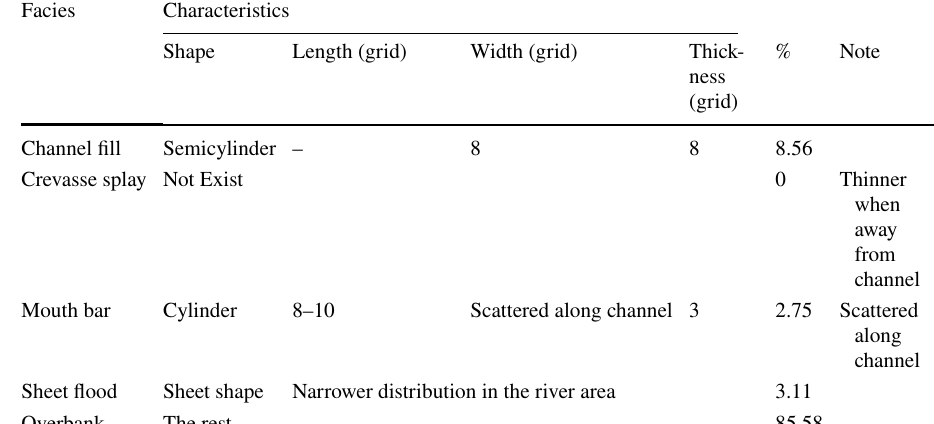
Table 2 Features of geology in